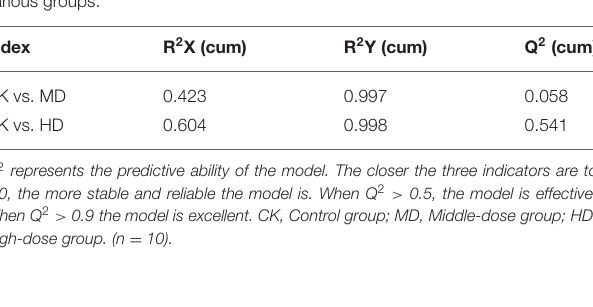
TABLE 2 | R 2 X, R 2 Y, and Q 2 of OPLS-DA in mouse brain tissue samples from various groups.